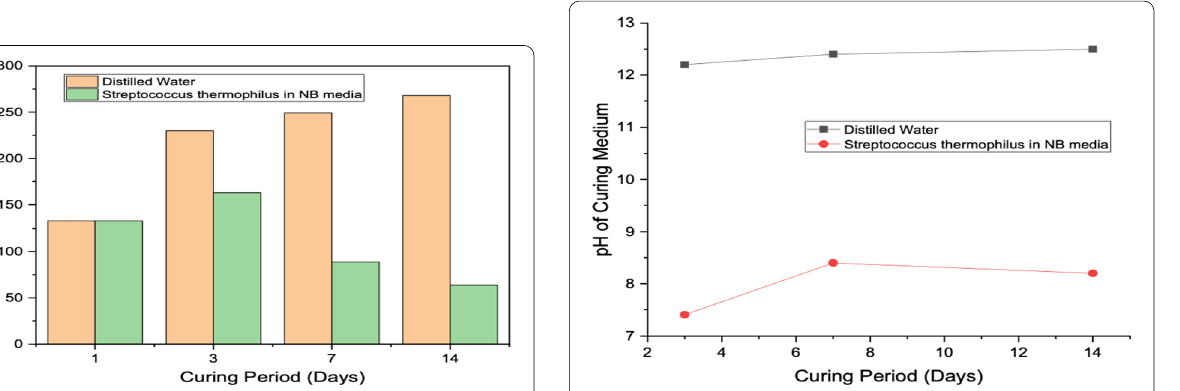
Fig. 4 pH values of distilled water (DW) and Streptococcus thermophilus bacteria in nutrient broth NB media at different curing